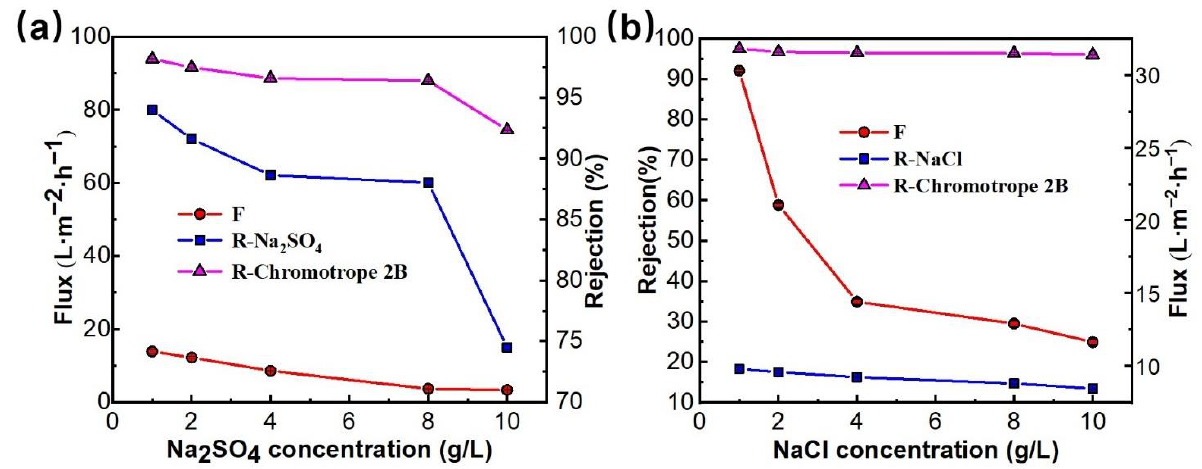
Figure 10. The effect of the inorganic salt (Na 2 SO 4 (a), NaCl (b)) concentration on separation performance of PMIA HF TFC NF membrane, test conditions: 0.35 MPa, 25 ± 1 °C.